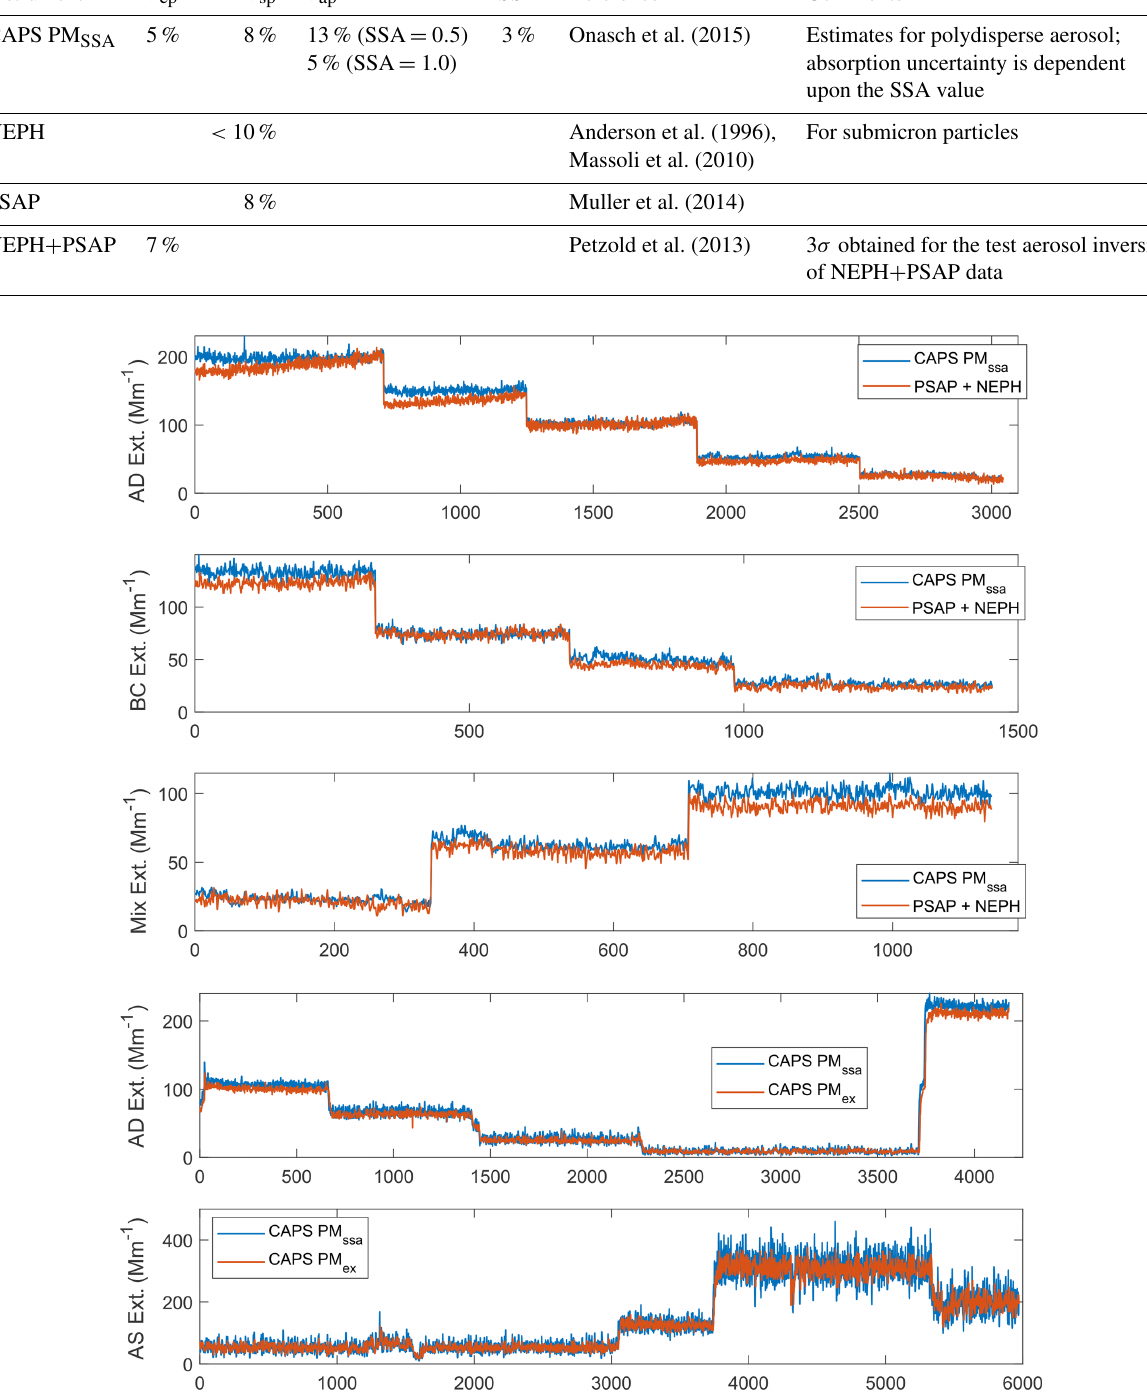
Table 6. Measurement relative uncertainties in the accuracy for the different instruments as reported by the relevant instrument papers. Instrument